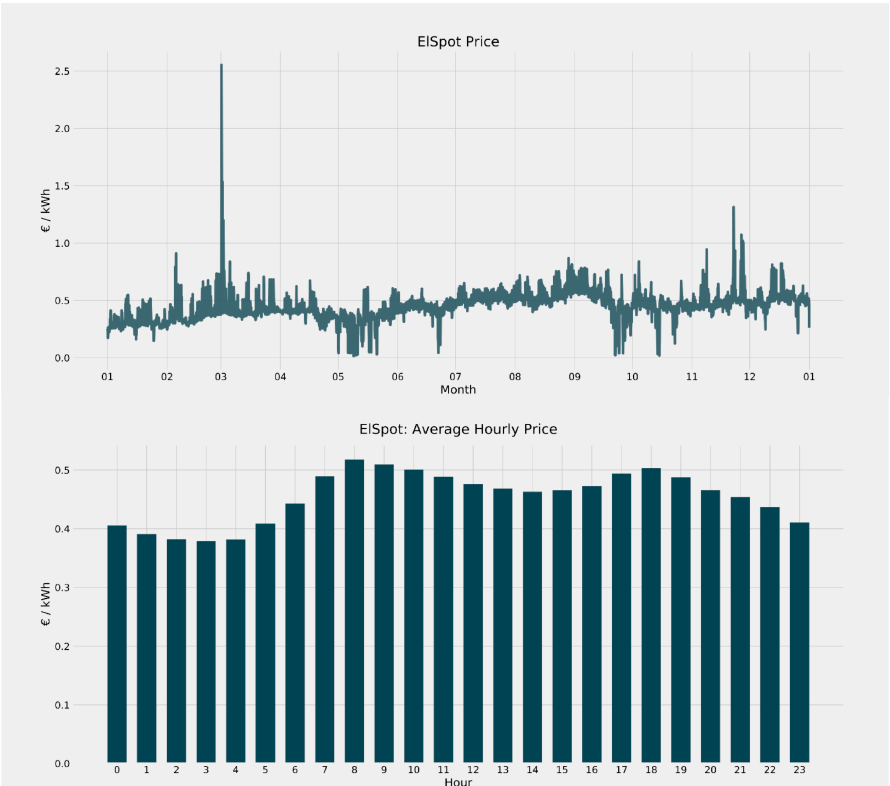
Figure 8. The annual variability of the spot market price ( top ) and the average aggregated hourly values ( bottom ) showing intra-day variability. Prices shown in EUR, and data shown for the year of 2018.